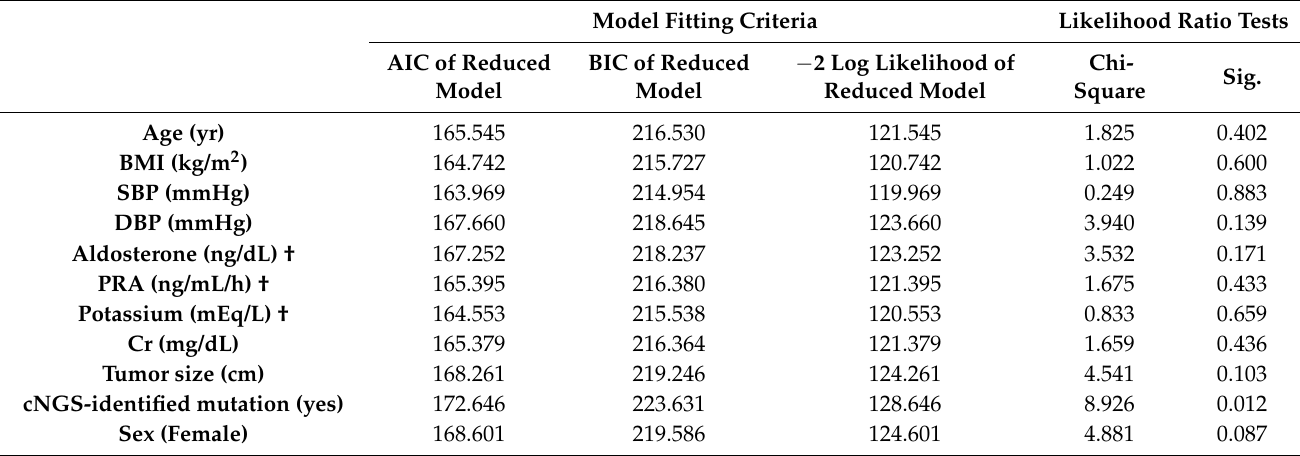
Table 3. Likelihood Ratio Tests of variables related to complete clinical success by multinomial logistic regression